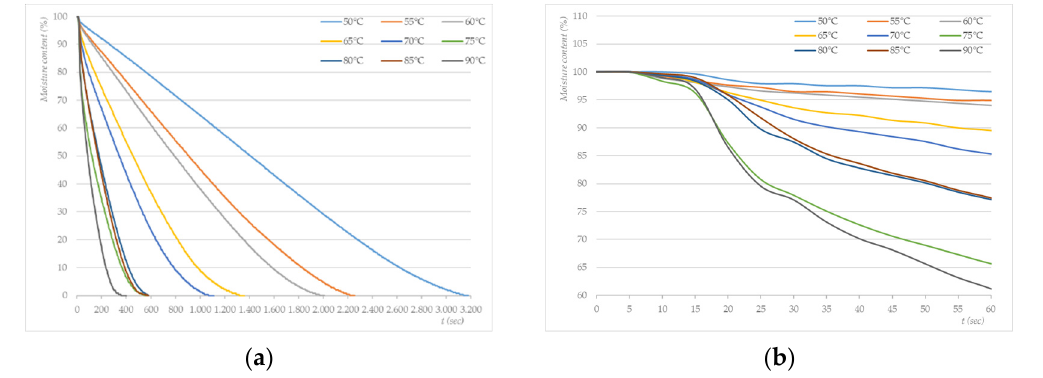
Figure 4. ( a ) Drying profiles of photothermally treated cotton swatches inoculated with S. aureus